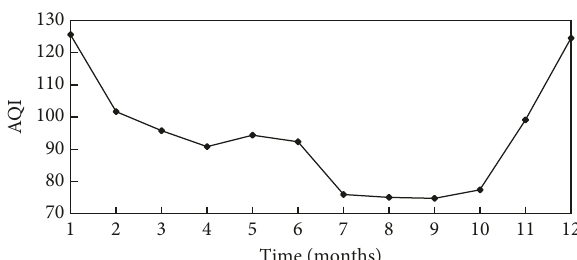
Figure 2: Annual AQI variation in Jiangsu Province in the period 2013–2017.